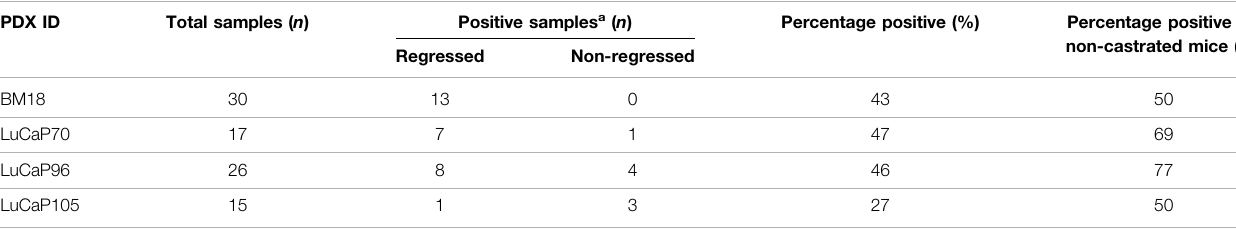
Regressed: tumour decreased in size following castration and weighed less than 0.3 g at endpoint analysis. a Samples with at least fi ve genes detected were considered